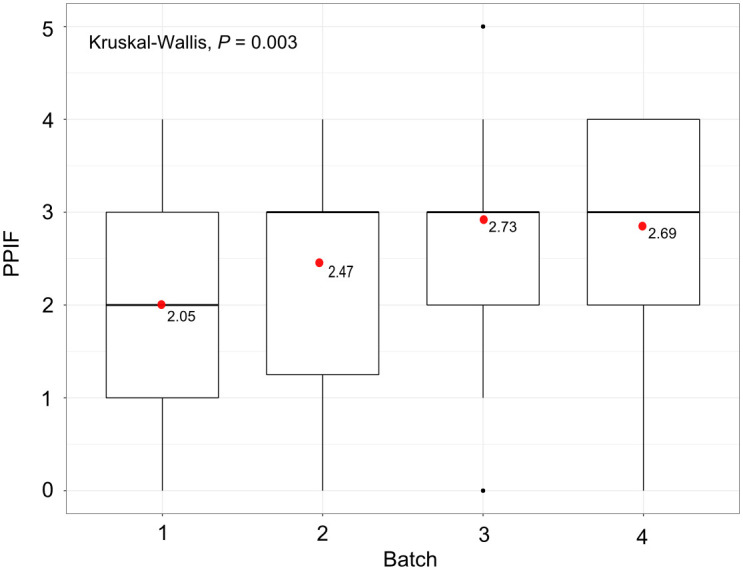
Number of pupae produced per initial female (PPIF) after 60 days according to the number of blood meals per week and the alternation of the days.The red points give the mean PPIF for each batch.